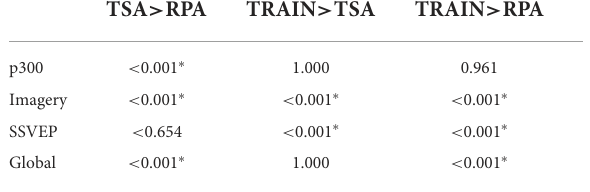
TABLE 4 Subject-wise p -values for MI database Cho 2017. TABLE 6 p -values for each paradigm and in global for all tests that have been done. The global p -values are the combination of the p -values for all databases regardless of their paradigm.